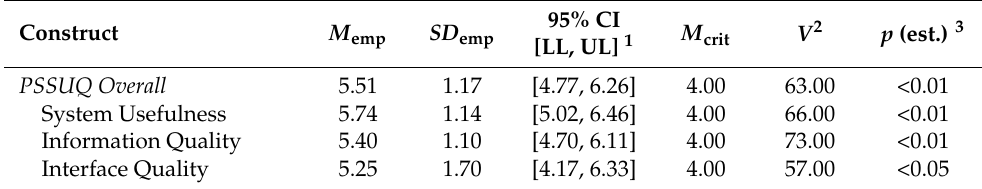
Table 7. Descriptive and inferential statistics regarding usability.